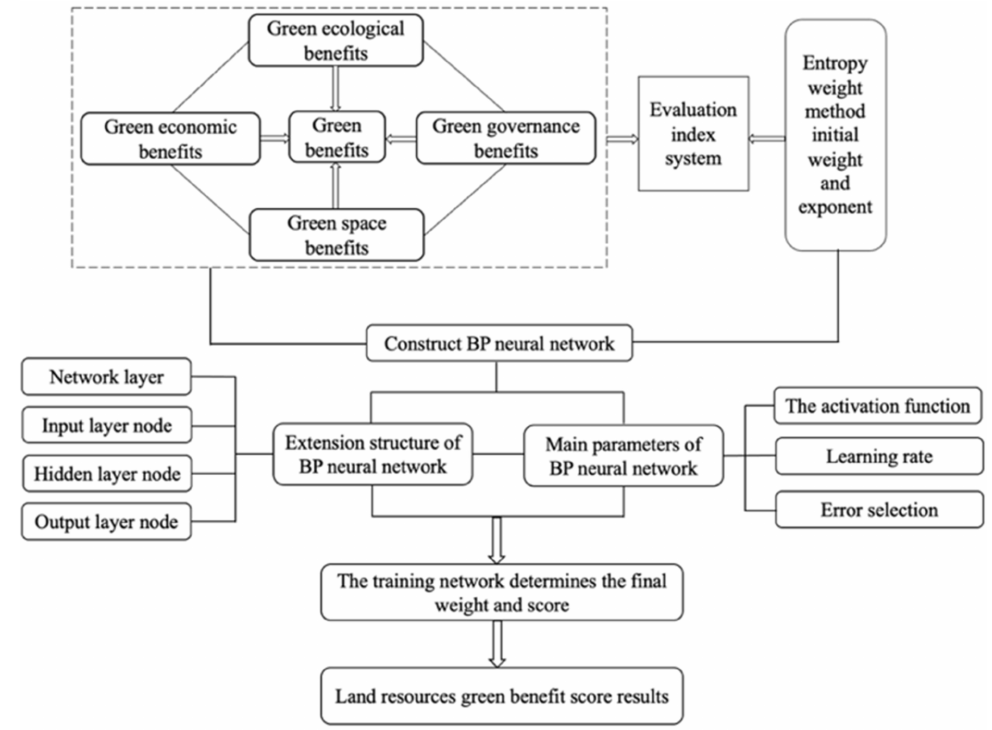
Figure 1. Theoretical framework and evaluation model of green land use